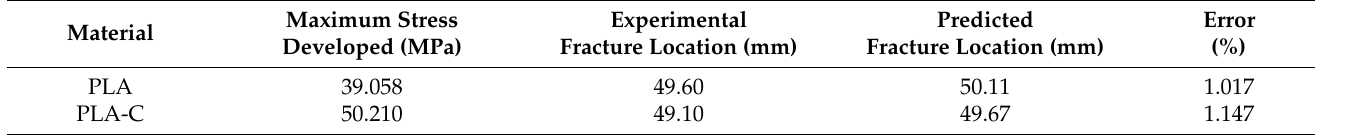
Figure 10. For PLA-C-based AFO, ( a ) simulated stress distribution, ( b ) high-stress location from sole in simulated result, and ( c ) location of fracture during experimentation. Table 5. Maximum stress generated at lower shank of AFOs and distance of fracture location from